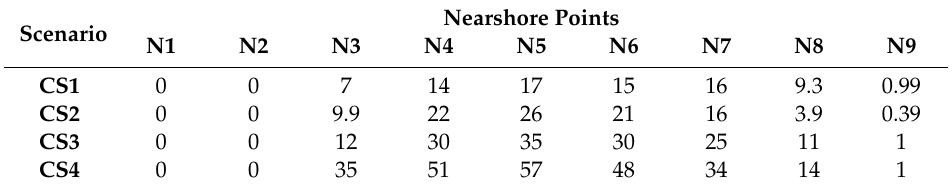
Table 4. Hs variation (%) corresponding to the N-points, considering a high energy summer event (summer B). The results were compared with the no farm scenario.